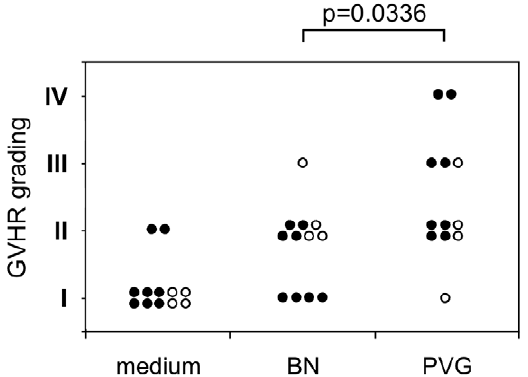
Figure 1. Induction of a GVHR in BN rat skin explants exposed to PVG lymphocytes. A summary of the histological GVHR grading of BN skin samples cultured in medium alone, together with syngeneic BN lymphocytes, and together with pre-stimulated allogeneic PVG lymphocytes (n=12 in each group) is given. The samples represented by closed circles were used for both gene expression profiling and qRT- PCR experiments, whereas the other samples were only used for gene expression profiling. The pair-wise comparison (U test) indicated a significant difference between skin explant cultures with BN and PVG